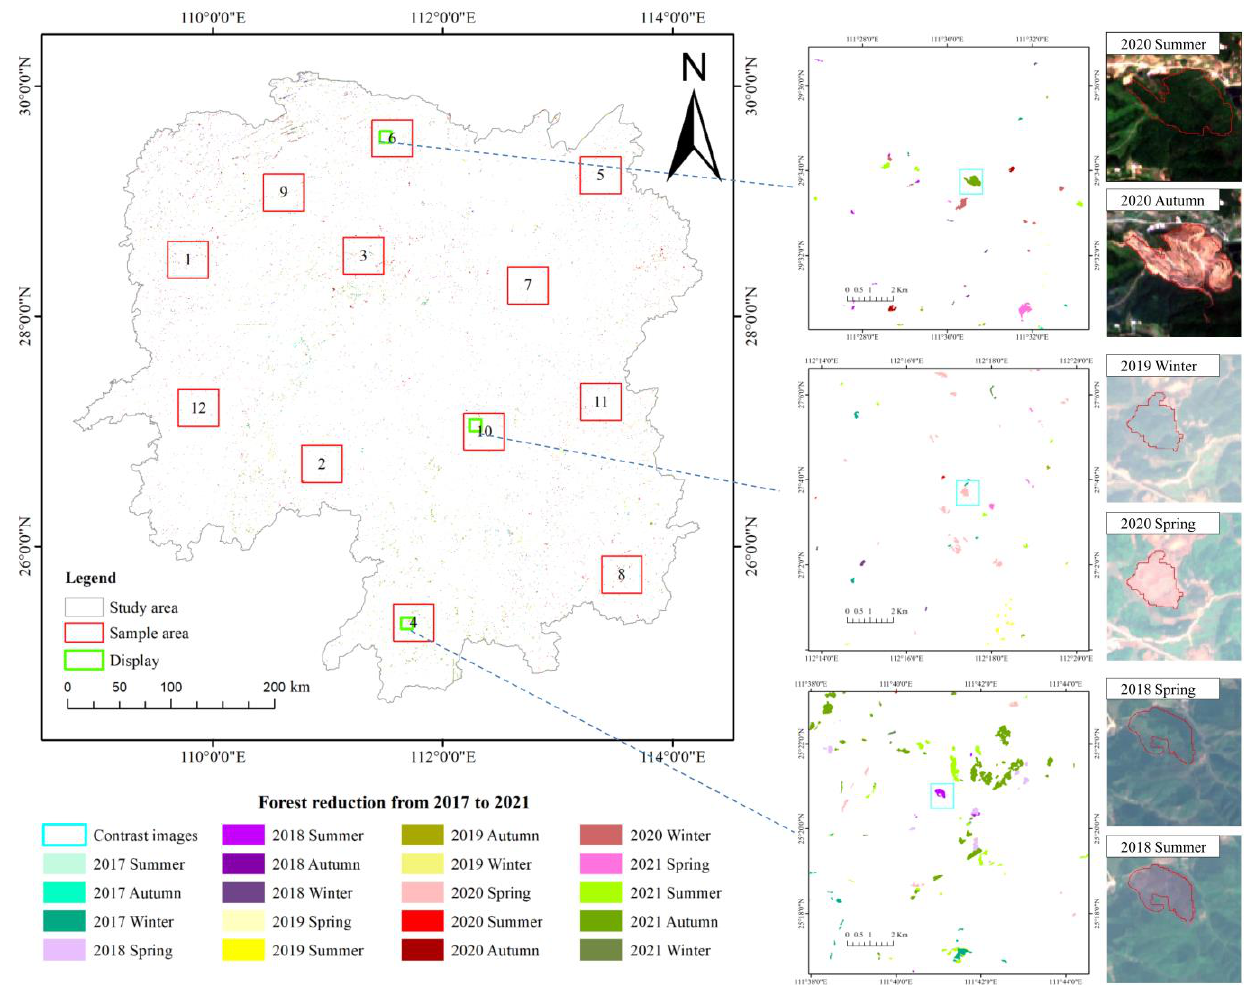
Figure 12. Results of the quarterly dynamic detection of forest change from 2017 to 2021. A total of 20 periods of Sentinel-2 predictions from 2017 to 2021 yielded a total of 19 forest change detection. No detection is available for this period as no pre-period images were available for spring 2017.